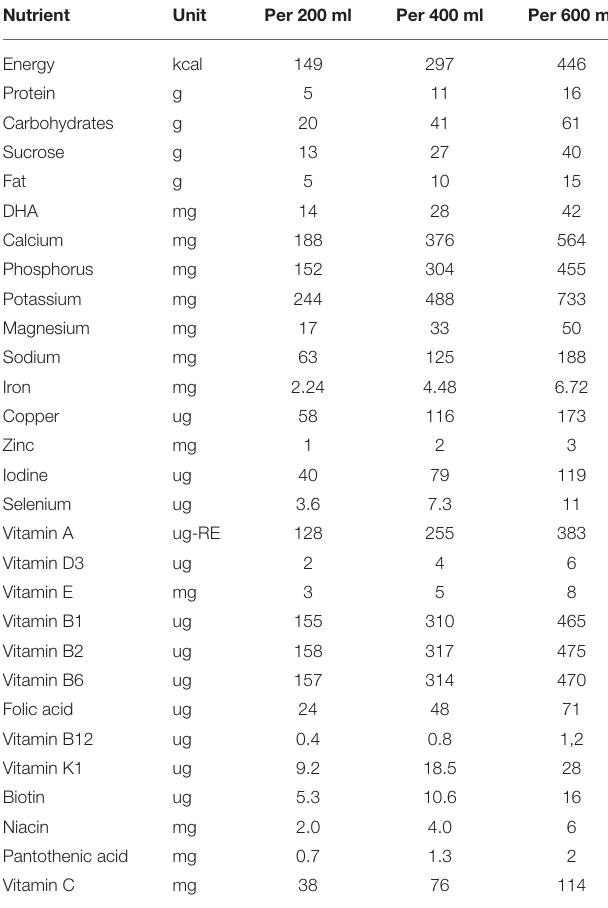
TABLE 1 | Composition of the multi-nutrient fortified dairy-based drink, provided to Nigerian toddlers with malnutrition in daily amounts of 200, 400 or 600ml, during 6